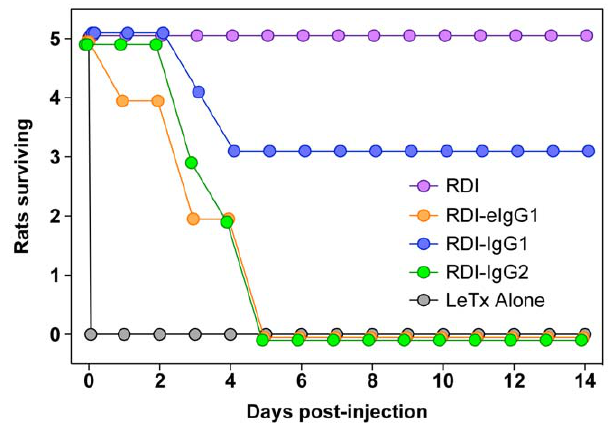
Figure 7. Delayed toxicity of rats following LeTx challenge with RDI-IgG1 and RDI-IgG2 fusion proteins. Male 200 gram HSD rats (5/group) were co-injected i.v. with LeTx (40 m g PA + 12 m g LF) and either 19 m g of RDI; or 49 m g of either RDI-eIgG1, RDI-IgG1, or RDI-IgG2. Rats were monitored and time of death recorded.